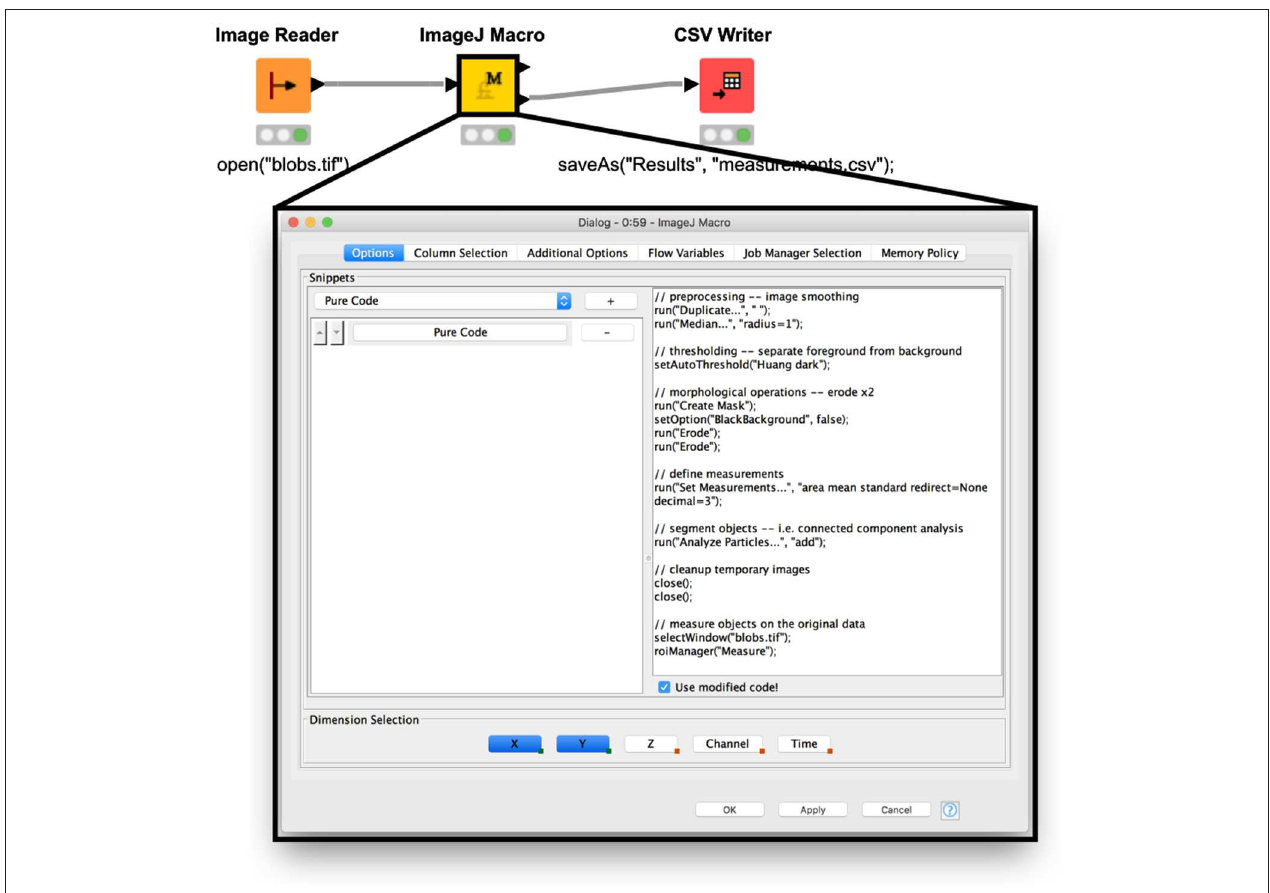
FIGURE 1 | An ImageJ Macro node performing image segmentation and feature